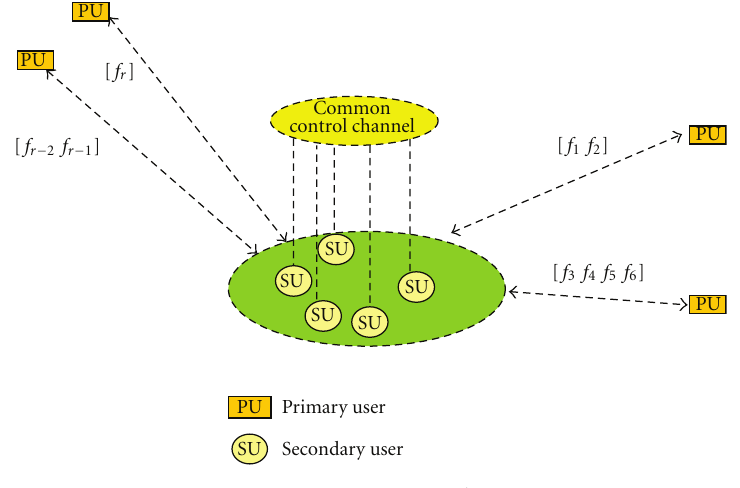
Figure 2: Usage scenario.